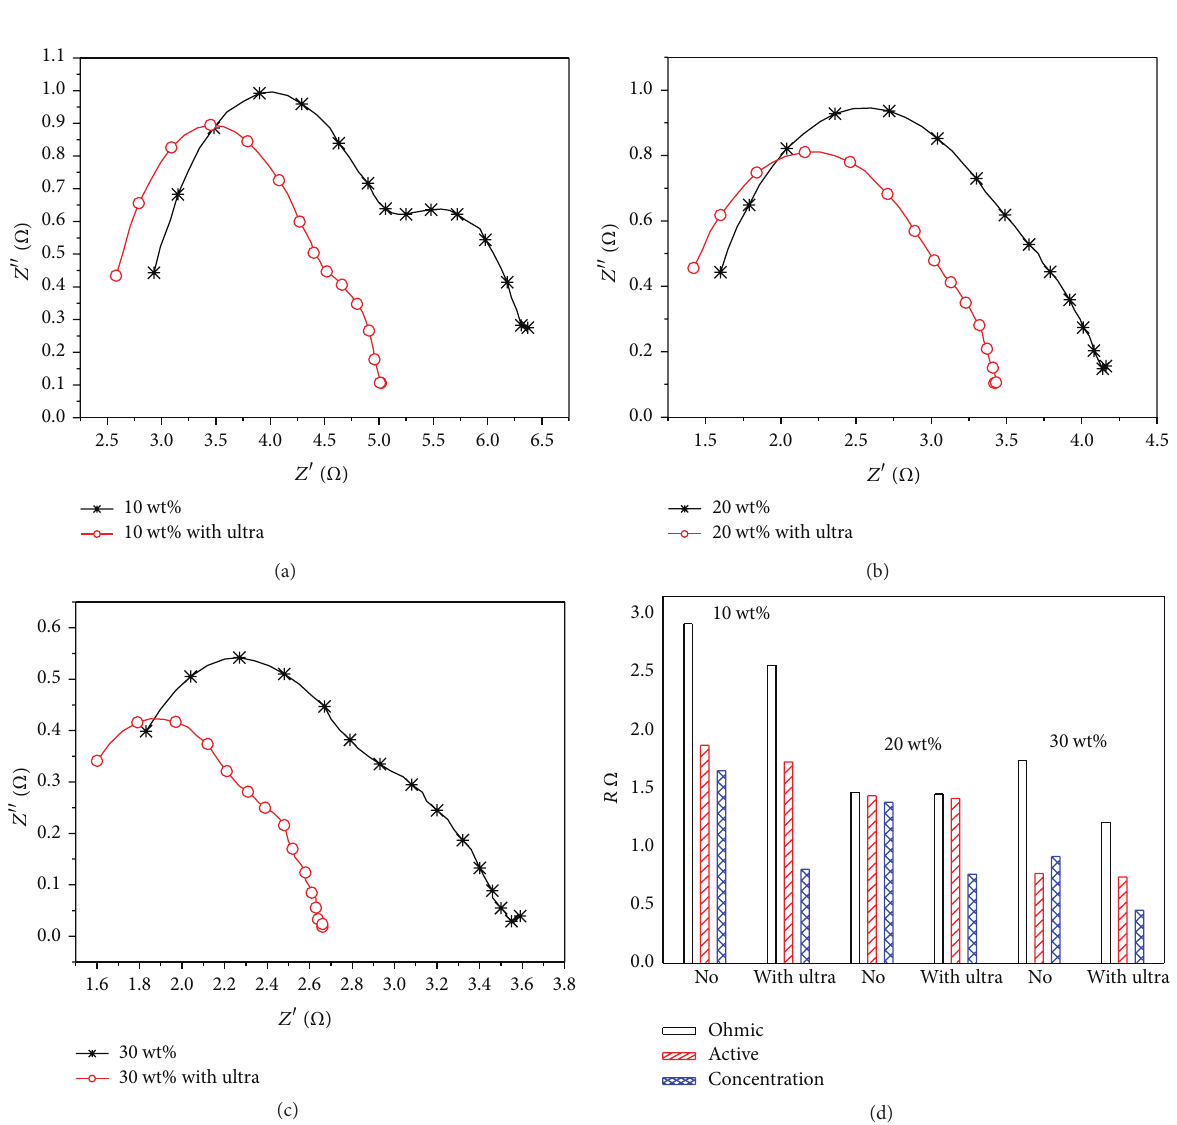
Figure 5: The Nyquist curves and polarization impedance chart at different electrolytes: (a) 10wt%, (b) 20 wt%, (c) 30wt%, and (d) polarization